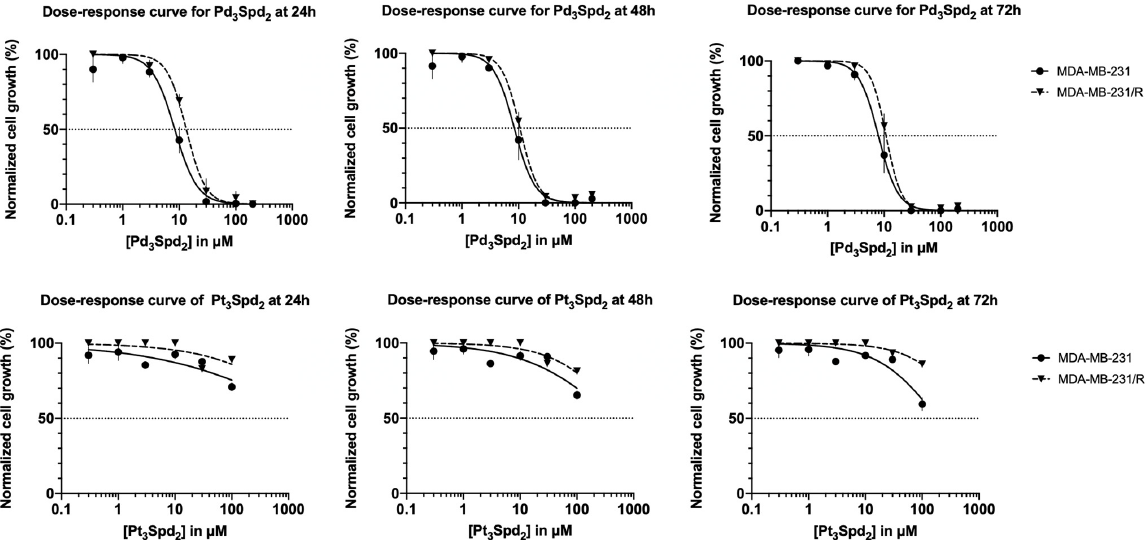
Figure 2. Impact of increasing concentrations of Pd 3 Spd 2 or Pt 3 Spd 2 on TNBC proliferation. Dose– response curves of Pd 3 Spd 2 ( upper panel ) and Pt 3 Spd 2 ( lower panel ) in breast cancer MDA-MB-231 and MDA-MB-231/R cells at 24, 48 and 72 h of incubation. Values are expressed as the mean ± SEM from 4 independent experiments (in triplicate) analyzed with nonlinear regression and the